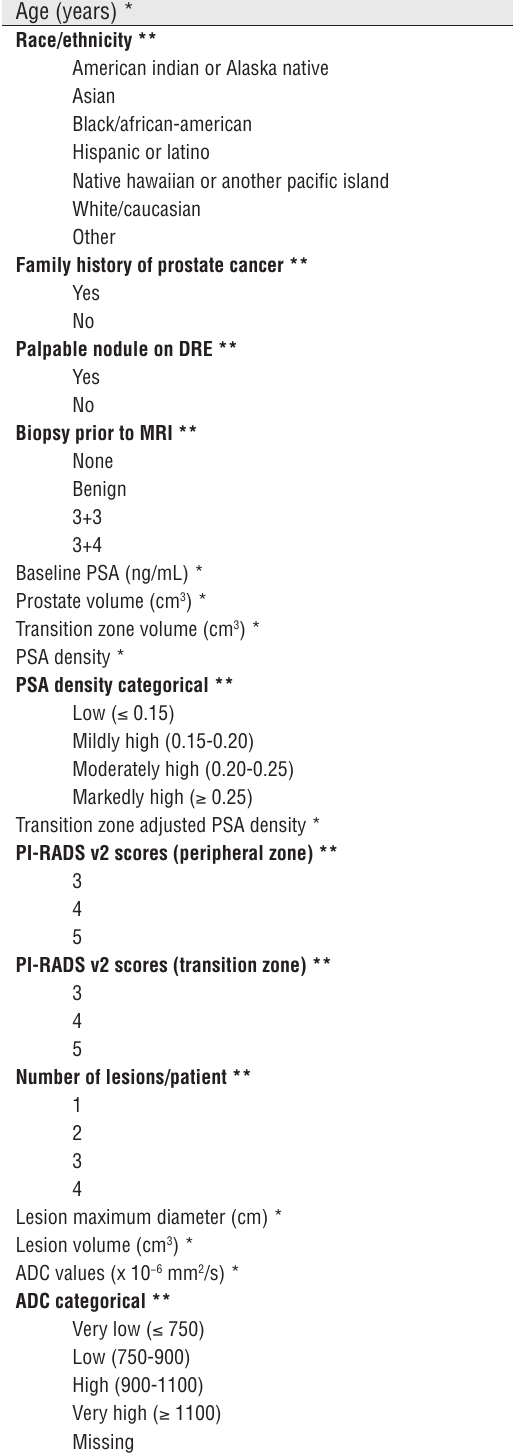
Table 1 - Baseline characteristics and imaging